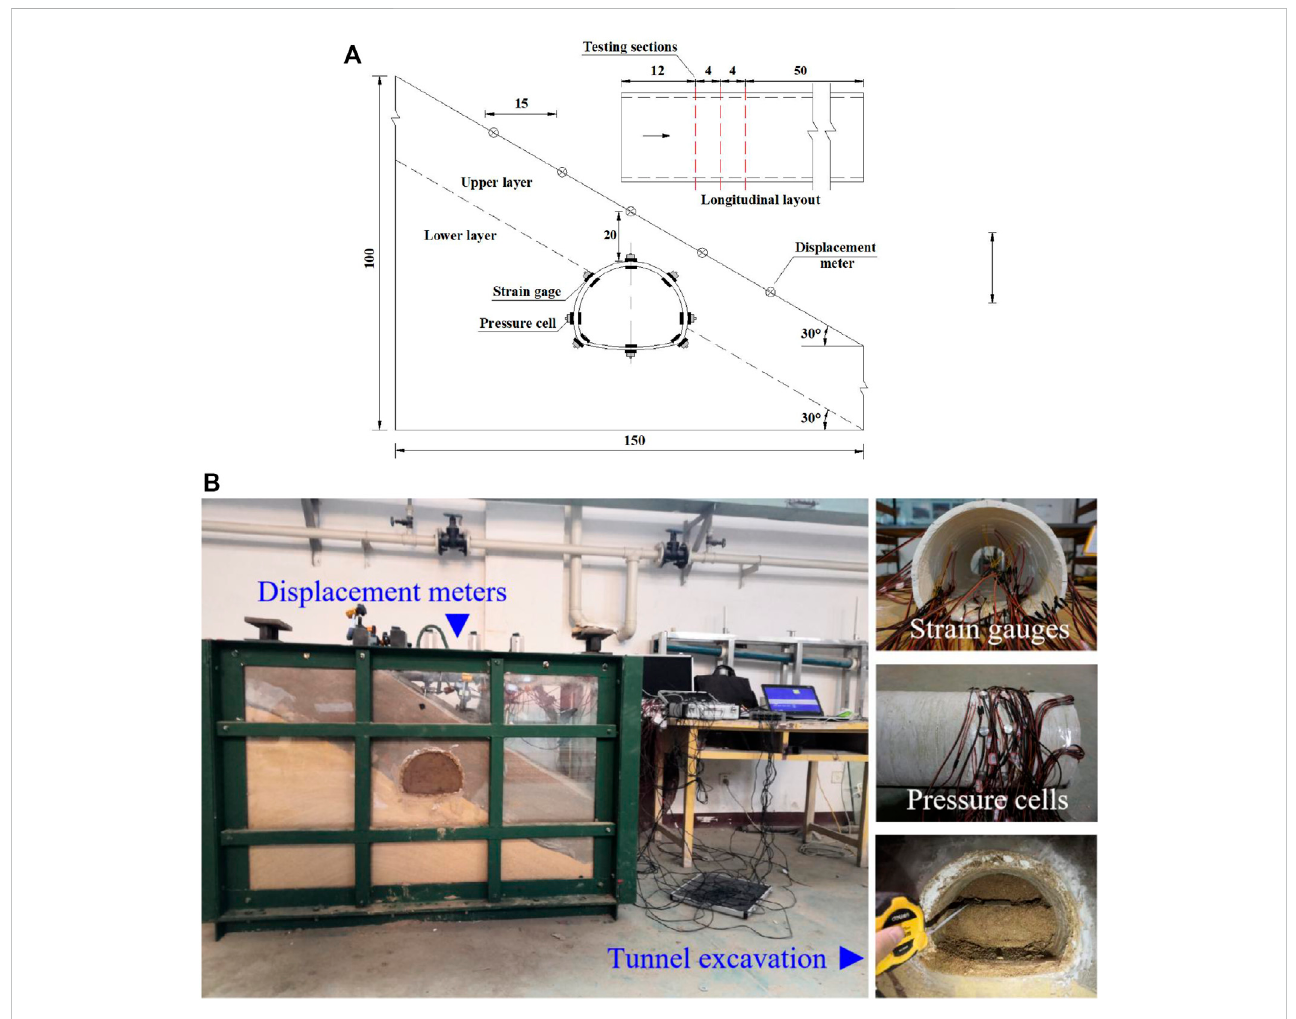
FIGURE 7 Model tests: (A) Cross-section layout of test elements and (B) Photographs of model tests.